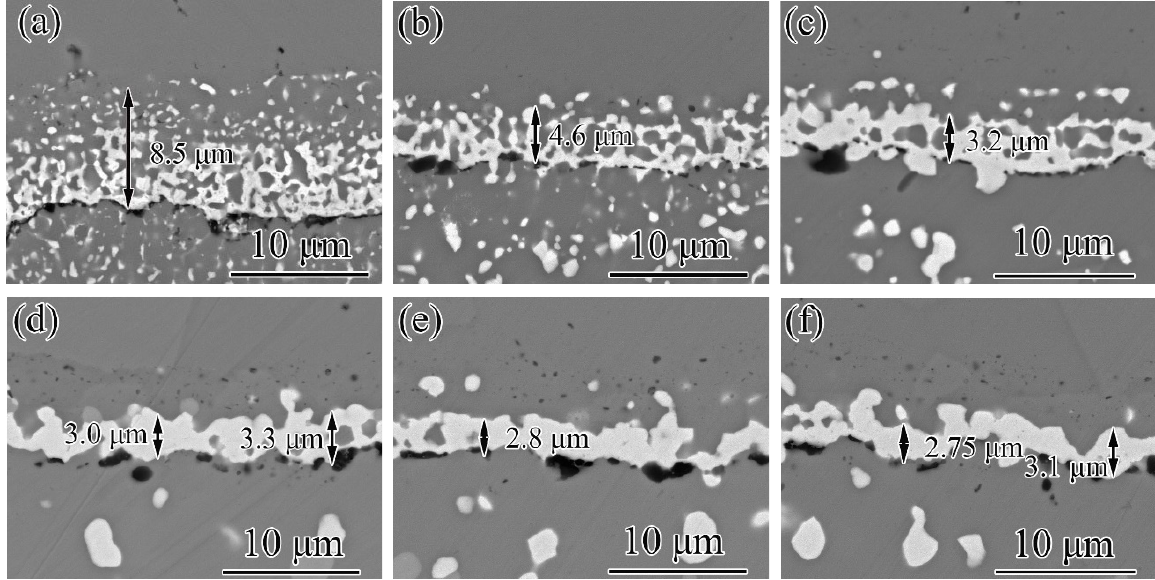
Fig. 47 Microstructure evolution of the Re-based DB during the isothermal oxidation test at 1100 ℃ for (a) 0 h, (b) 20 h, (c) 100 h, (d) 200 h, (e) 500 h, and (f) 1000 h. Reproduced with permission from Ref. [246], © Elsevier Ltd.